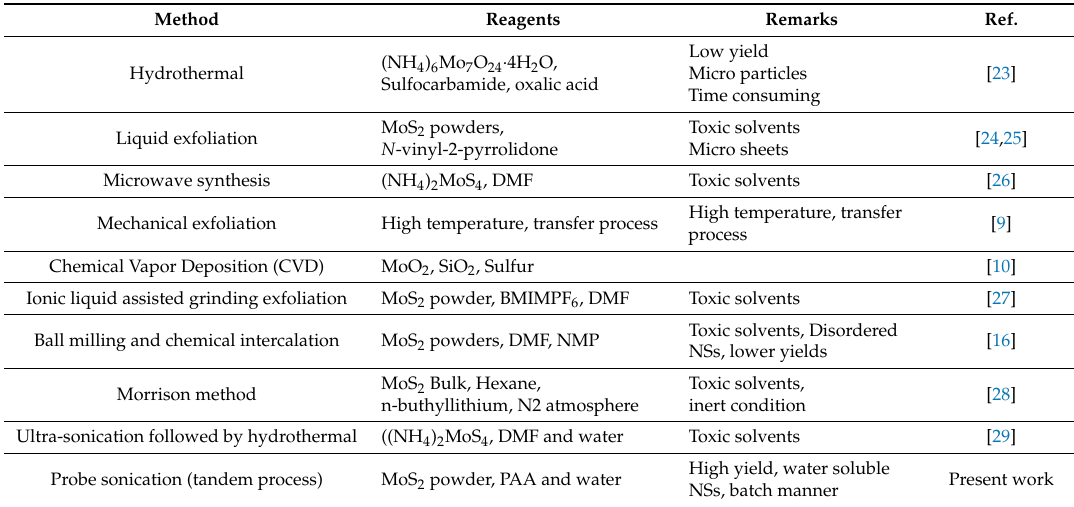
Table 1. Reported literature comparison of various fabrication methods of MoS 2